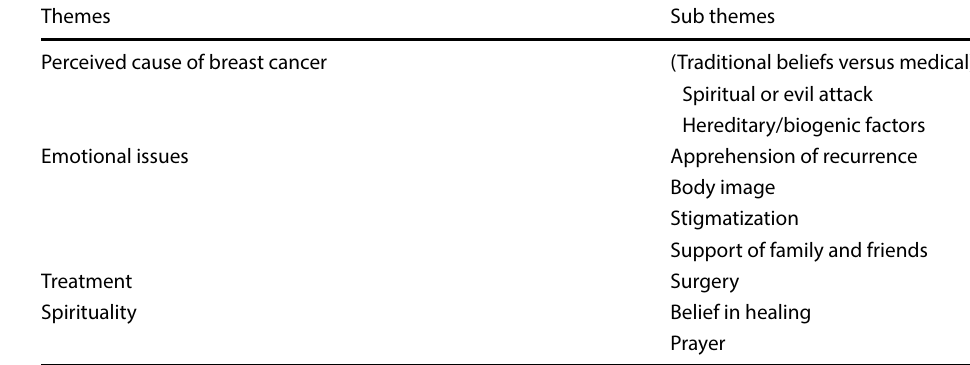
Table 3 Themes developed from the data